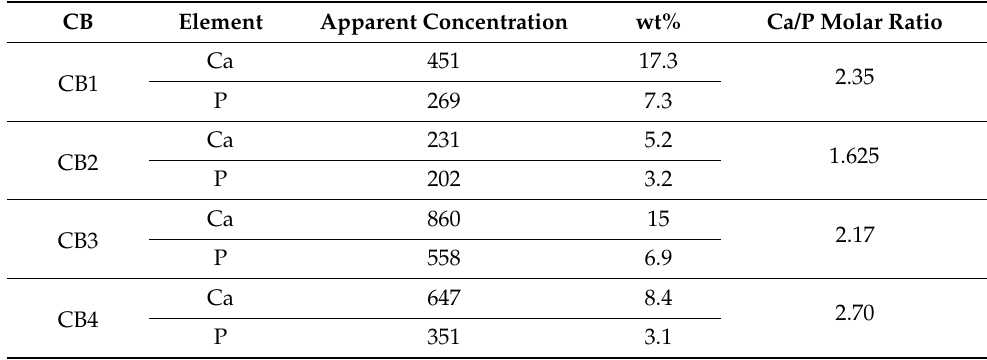
Table 2. Ca/P ratio calculated from EDX elemental